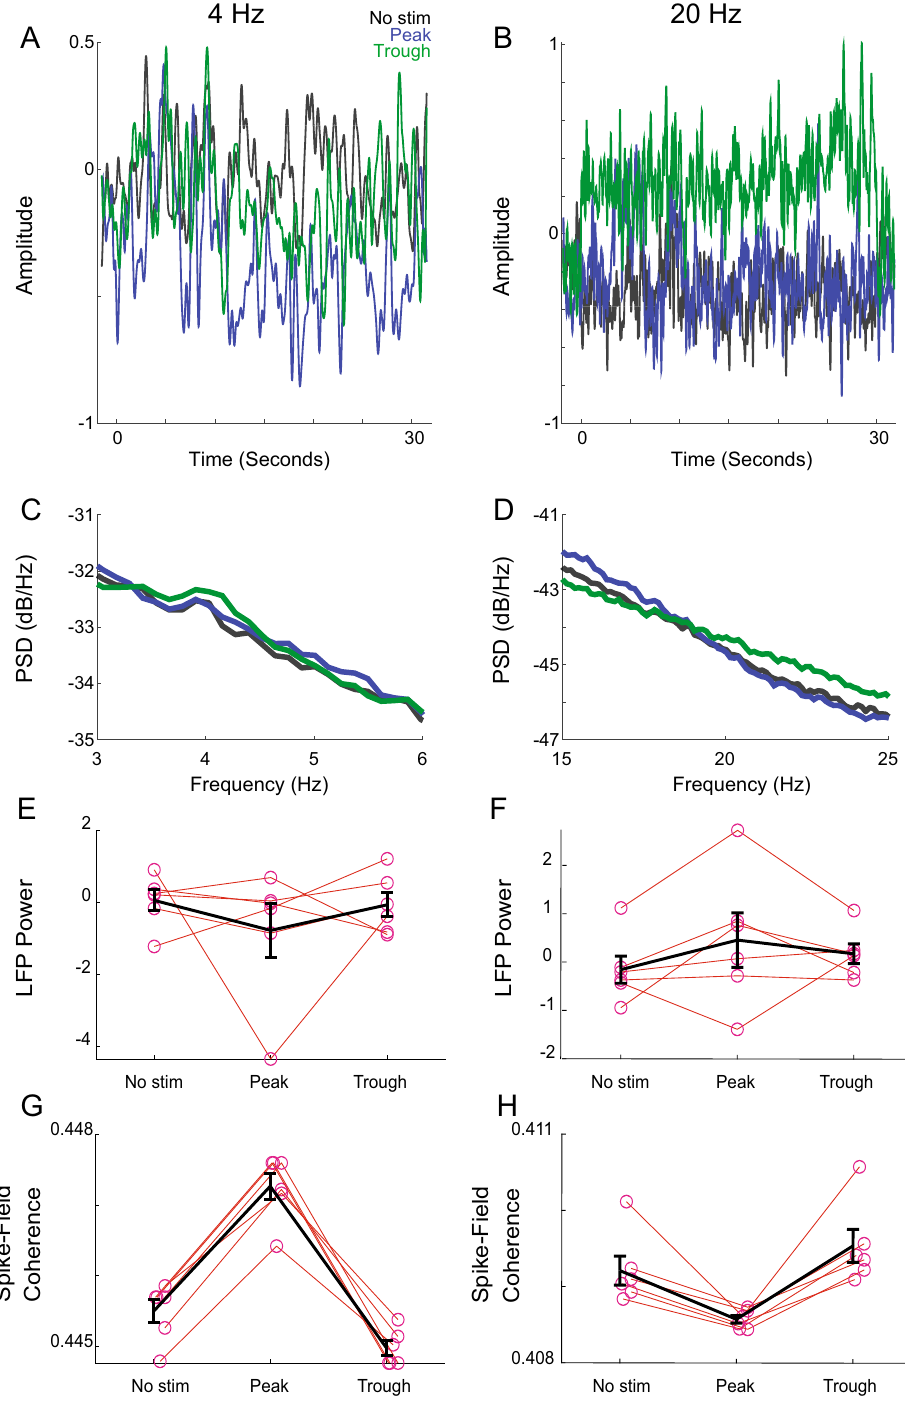
Figure 5. Closed-loop striatal stimulation changes spike-field coherence but not LFPs. ( A ) Raw traces from 4 Hz stimulation sessions during 30-s epochs without no stimulation (No stim; black), with peak PABST (blue), and trough PABST (green). ( B ) Raw traces for 20 Hz stimulation. ( C ) Power spectral density for 4 Hz PABST sessions, and for ( D ) 20 Hz PABST sessions. There were no reliable effects of peak vs. trough closed-loop stimulation on striatal power at ( E ) 4 Hz or at ( F ) 20 Hz. However, we noticed that ( G ) 4 Hz peak-stimulation spike-field coherence was increased relative to trough spike-field coherence, whereas for ( H ) 20 Hz stimulation trough stimulation had a higher spike-field coherence than peak stimulation. Data from six dopamine-depleted